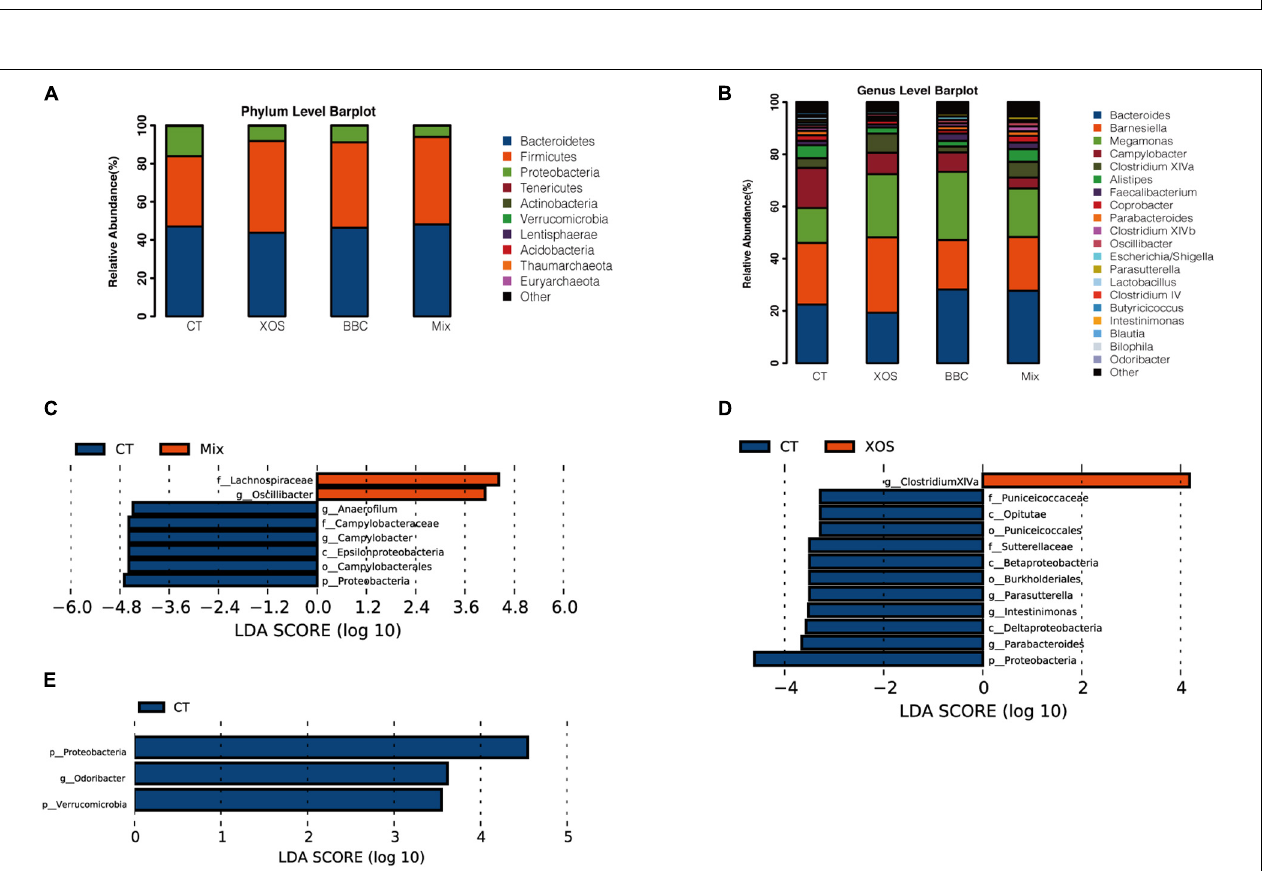
FIGURE 2 | Relative abundance of the dominant bacterial communities at phylum (A) and genus (B) level and log-transformed linear discriminant analysis (LDA) scores of the significant biomarkers of MIX vs CT group (C) , XOS vs CT group (D) and BBC vs CT group (E) .